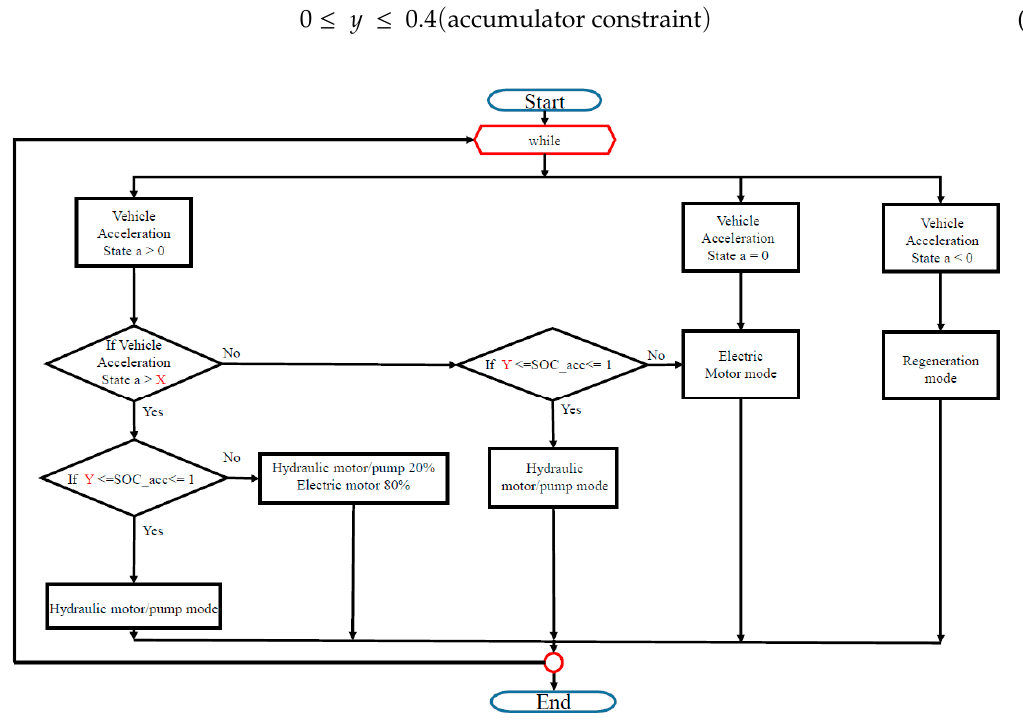
Figure 6. Control flow of genetic algorithm.